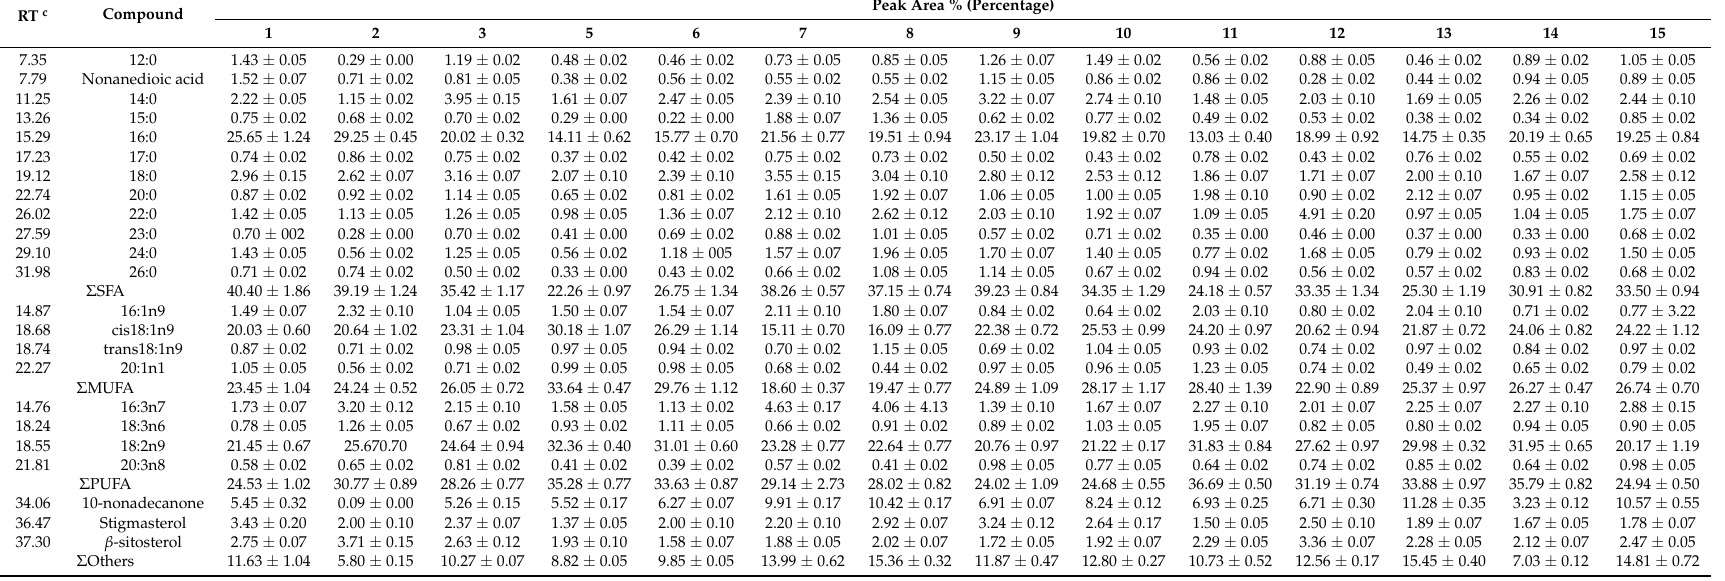
Table 2. Chemical composition of fatty acids extracted from the aerial parts of Bupleurum scorzonerifolium Willd. from different countries or regions (as methyl